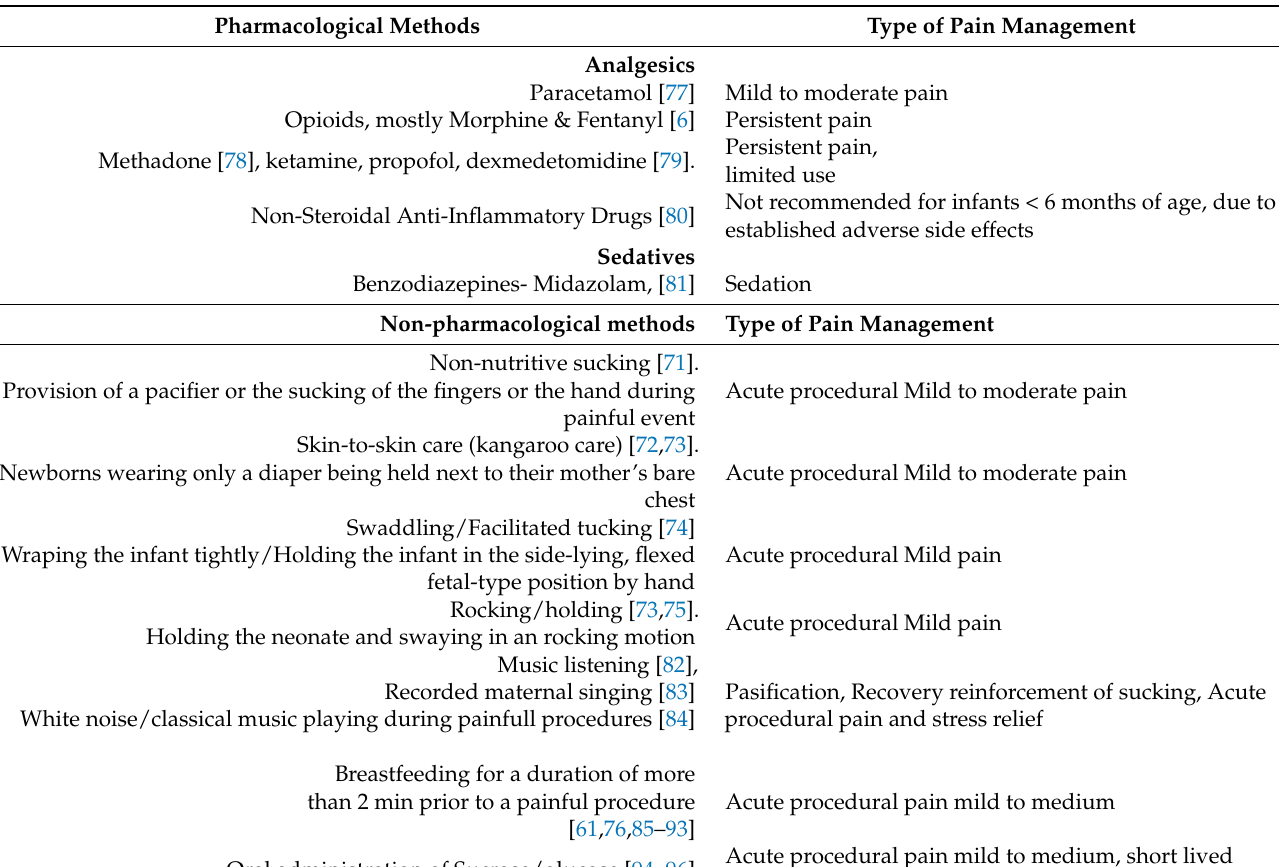
Table 2. Most common pain management methods in